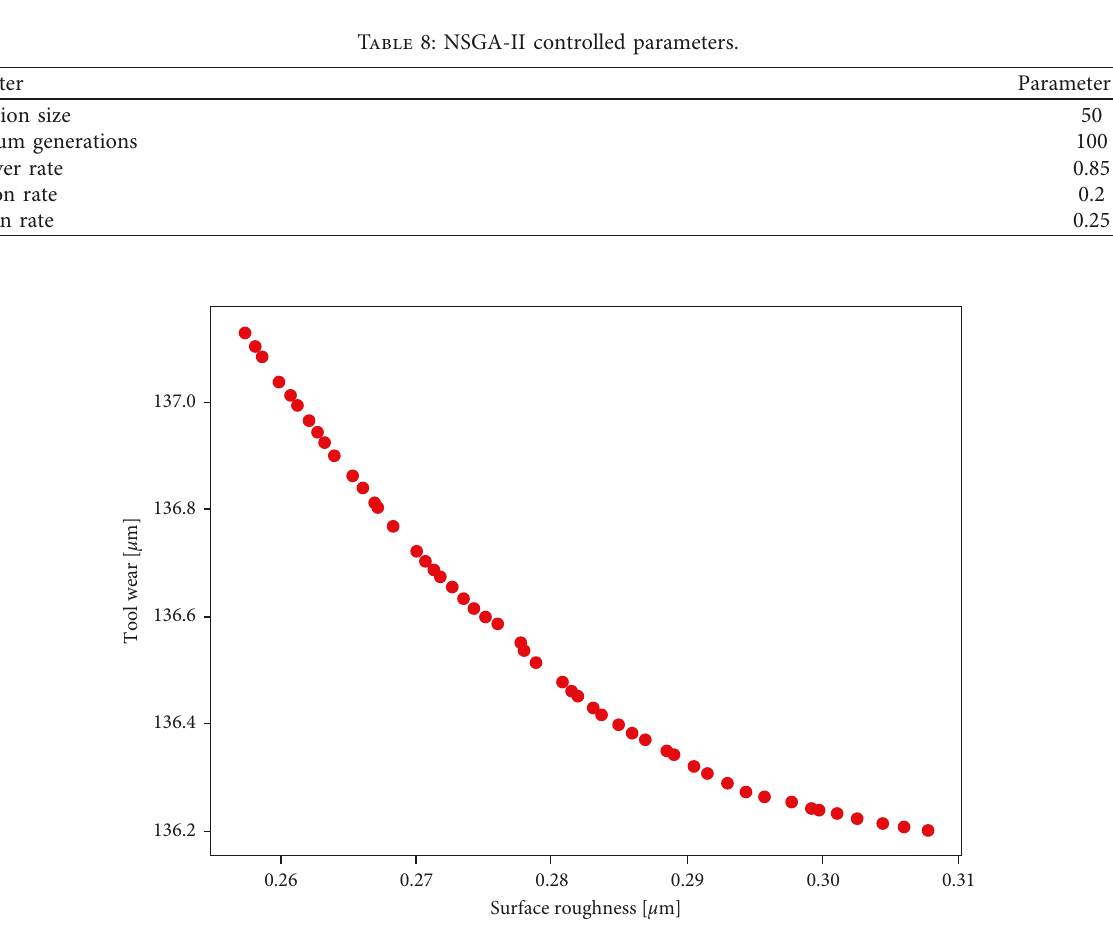
Figure 12: Pareto front of nondominated results. Table 9: Range of values in Pareto solutions generated by multiobjective